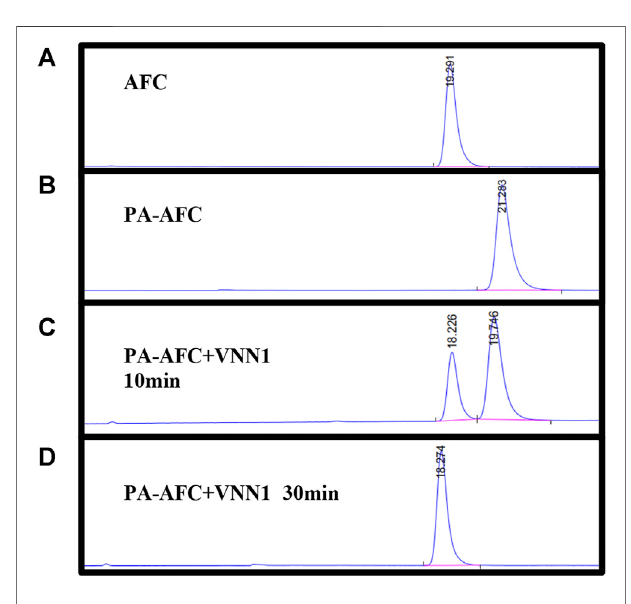
FIGURE 1 | HPLC veri fi ed the reaction mechanism between fl uorescent probe PA-AFC and pantothenate: (A) fl uorophore AFC (0.2 mM); (B) fl uorescent probe PA-AFC (0.2 mM); (C) probe PA-AFC (0.2 mM), 1 ml) and pantothenate (500 ng/ml, 1 ml) incubate at 37 ° C for 10 min, and then fi lter and inject; (D) probe PA-AFC (0.2 mM, 1 ml) and pantothenate (500 ng/ ml, 1 ml) After incubating at 37 ° C for 30 min, fi lter injection.